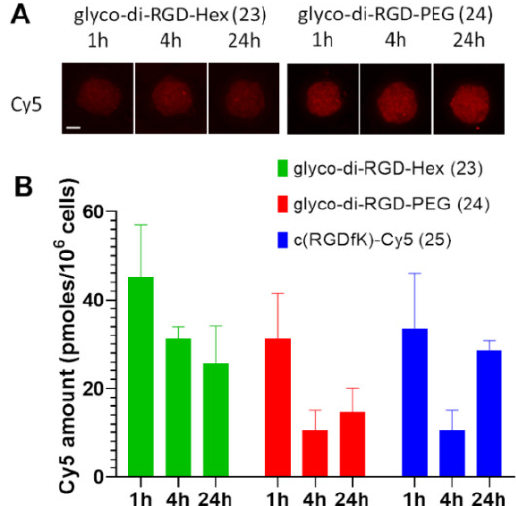
Figure 3. Cellular uptake of fluorescent conjugates 23 and 24 . ( A ) Confocal microscopy on U-87 MG spheroids was incubated for 1, 4, and 24 h with fluorescent conjugates 23 , 24 or c(RGDfK)-Cy5 ( 25 ) at 1 µ M. The intrinsic fluorescence of the compounds corresponds to Cyanine 5 (red fluorescence, λ ex 631/28 nm, λ em 692/40 nm). Scale bar represents 100 µ m. ( B ) Quantification of Cy5 incorporation by U-87 MG cells at 1, 4, and 24 h of incubation. The amount of each compound was calculated using the fluorescence of Cy5 extrapolated from the calibration curves of each compound and normalized to 10 6 cells. n = 3.